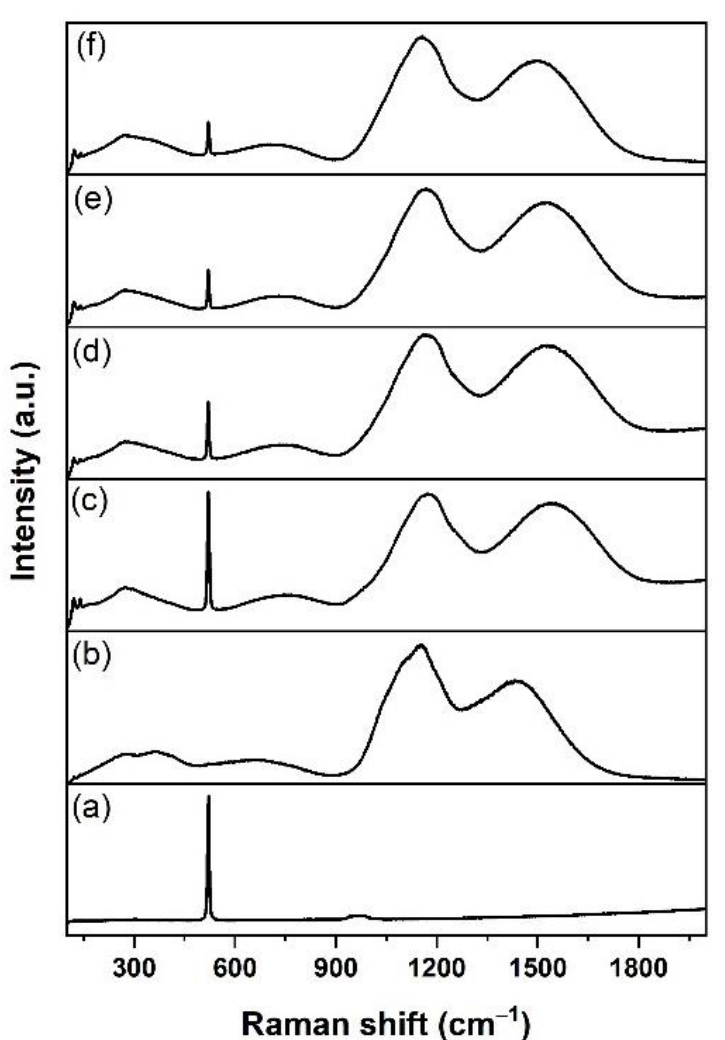
Figure 15. Raman spectra of ( a ) Si 3 N 4 -on-silicon substrate and samples ( b ) K470, ( c ) K520, ( d ) K570, ( e ) K600 and ( f ) K650.